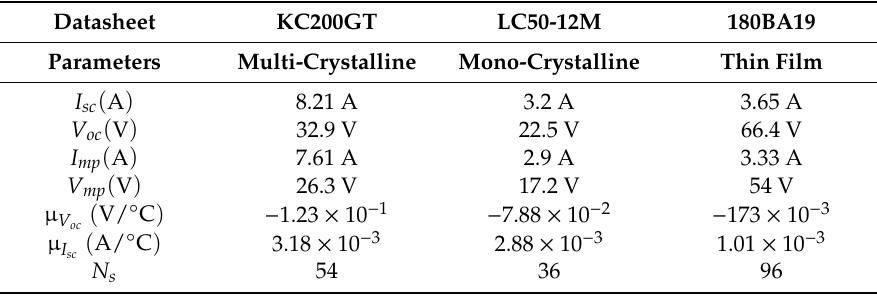
Table 1. Parameters for the Multi-crystalline (Kyocera KC200GT).